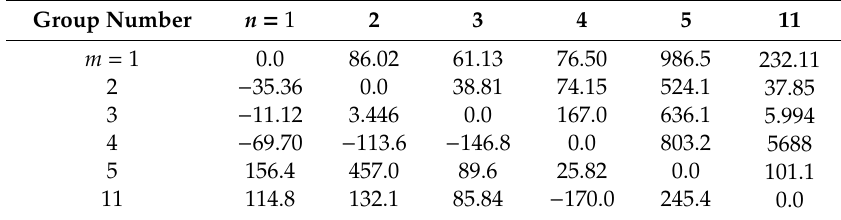
Table A2. The m -group and n -group interaction parameters ( a mn ) in K, used in the UNIFAC and UNIFAC–VISCO